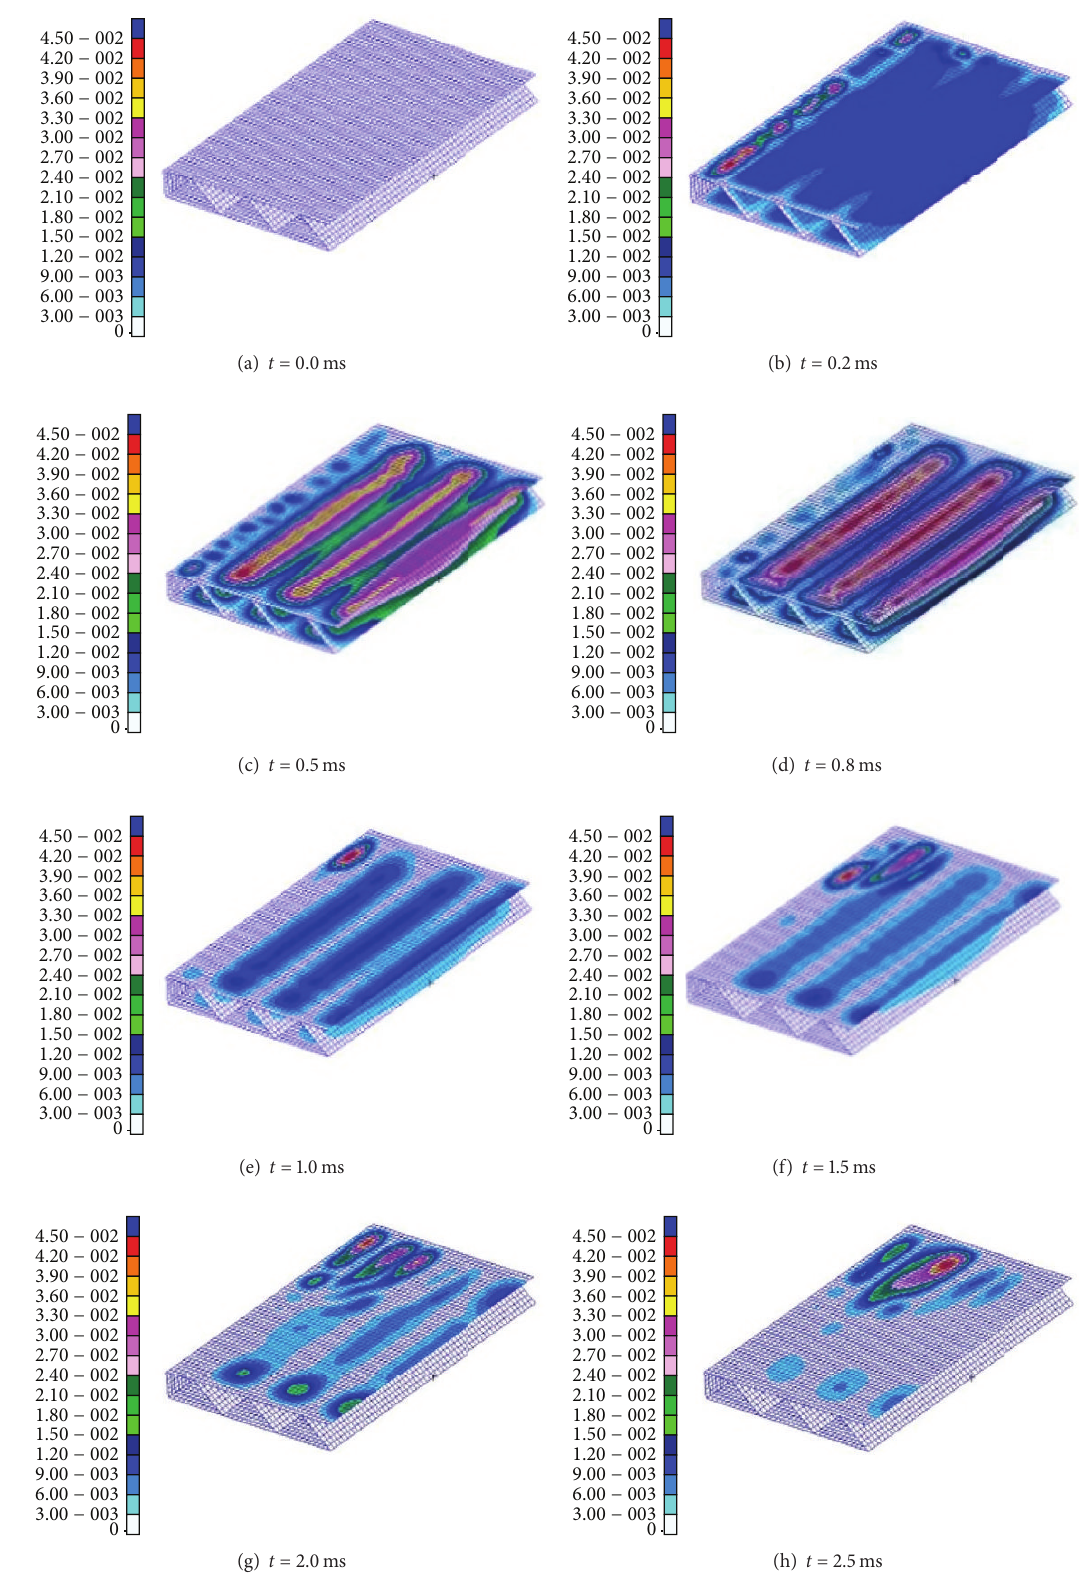
Figure 18: Deformation of case 2 ( W = 0.05 kg, d = 0.3